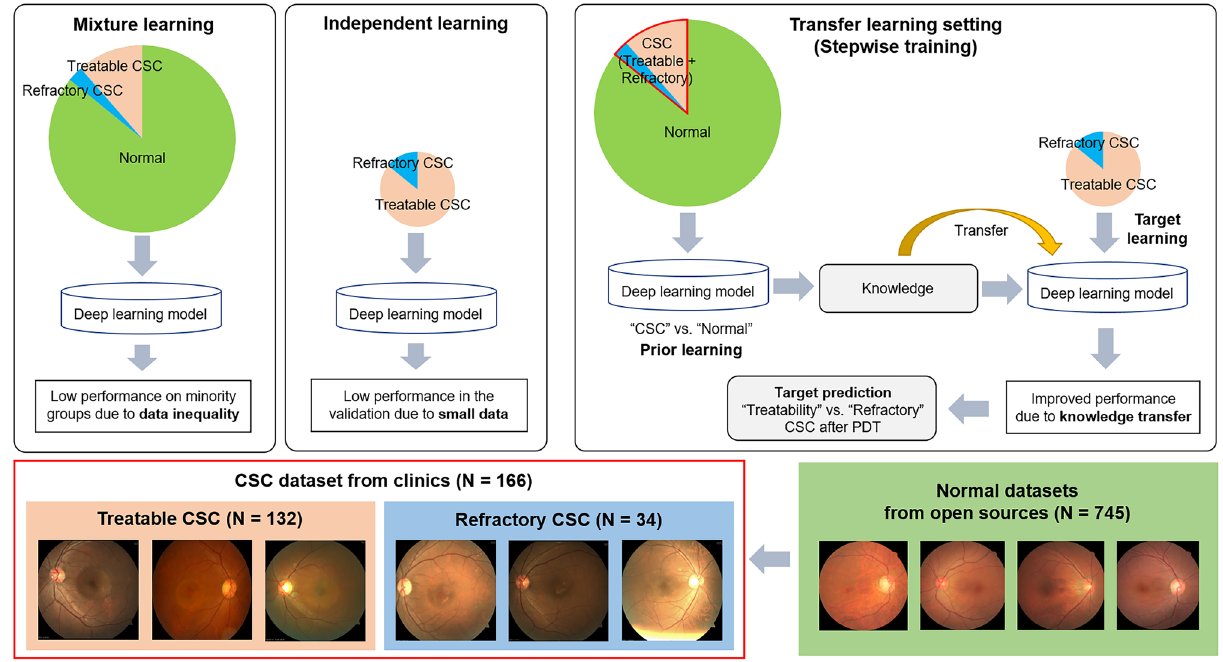
Figure 5. The stepwise transfer learning scheme to classify treatable and refractory central serous chorioretinopathy (CSC) for photodynamic laser therapy